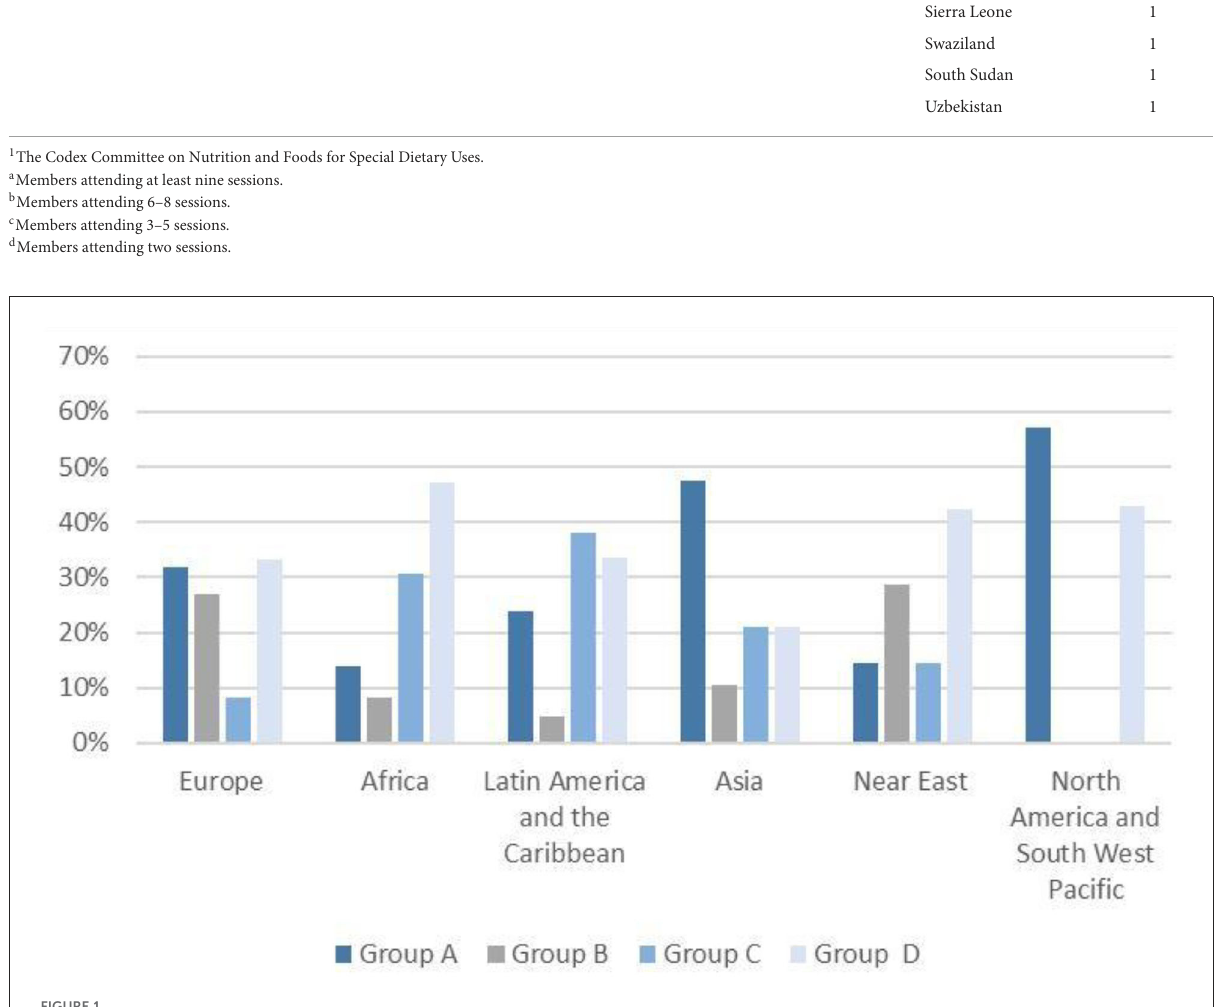
Colombian (63.9%), and the Swiss (59.4%) delegation. Group D did not have any private sector representatives, except for the Congo delegation participating in